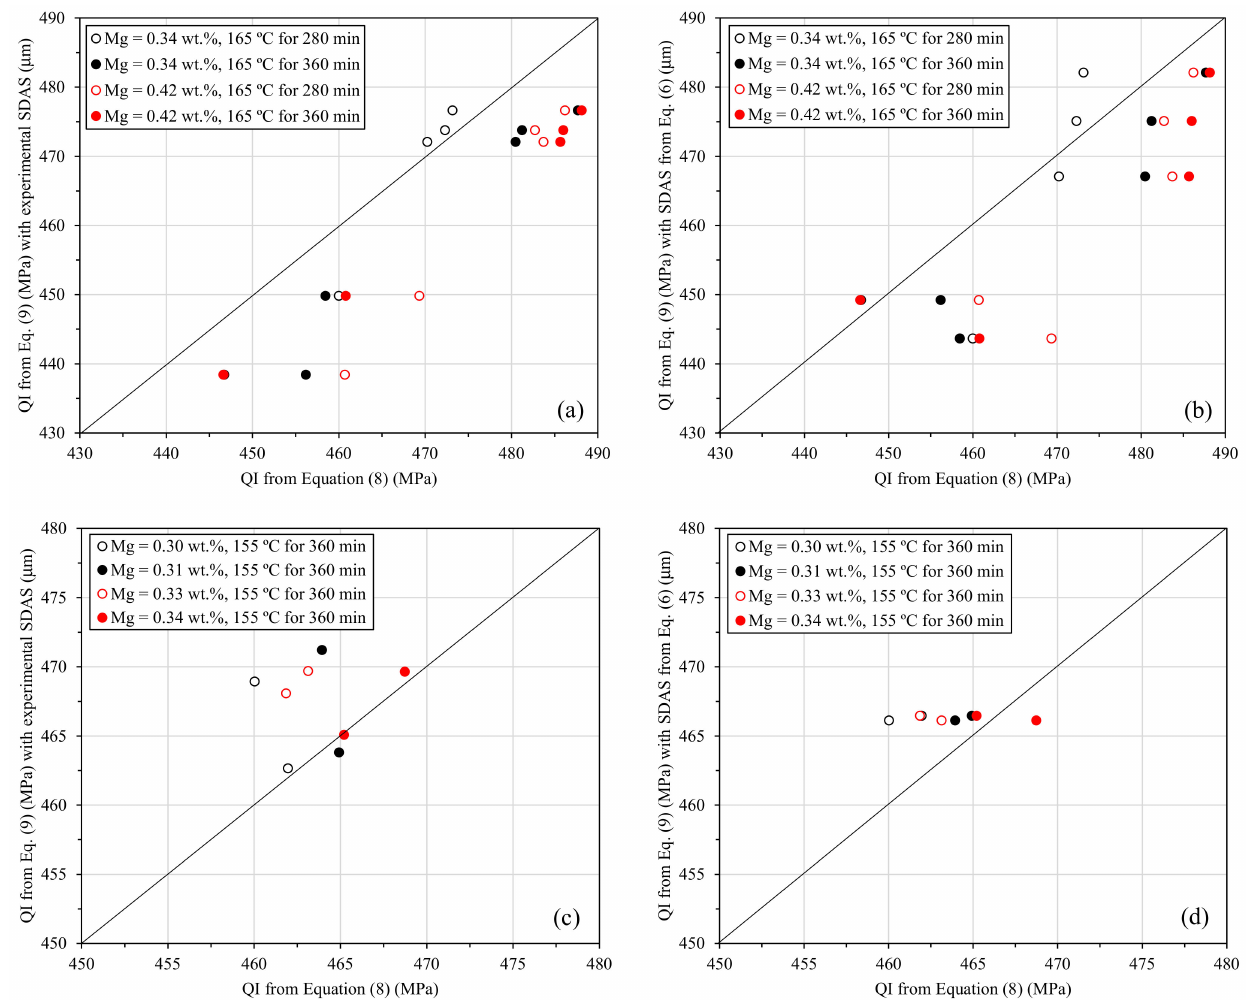
Figure 18. Comparison of QI values calculated with Equation (9) and those determined by using Equation (8). For the former equation experimentally measured SDAS ( a , c ) and the values of this parameter determined with Equation (6) ( b , d ) were used. The two graphs in the top row correspond to casting SK-7 while the two ones in the bottom row were obtained with data from castings SK-8. In case of SK-7 castings black and red circles correspond to the castings manufactured with 0.34 wt.% Mg and 0.42 wt.% Mg, respectively. In these two cases, open and solid symbols represent those castings aged at 165 ◦ C for 280 min and at 165 ◦ C for 360 min, respectively. For SK-8 castings increasing Mg content is given by black open (0.30 wt.%), black solid (0.31 wt.%), red open (0.33 wt.%) and red solid circles (0.34 wt.%). Solid lines are the